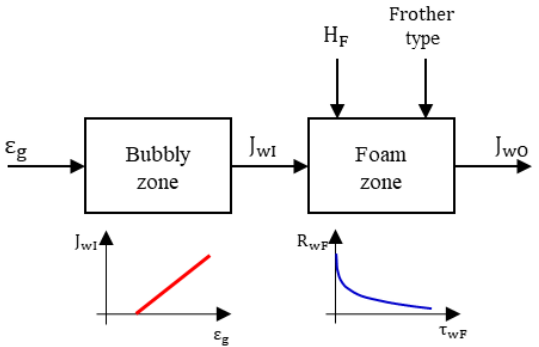
Figure 9. Block representation of the mathematical model to predict water recovery rate.